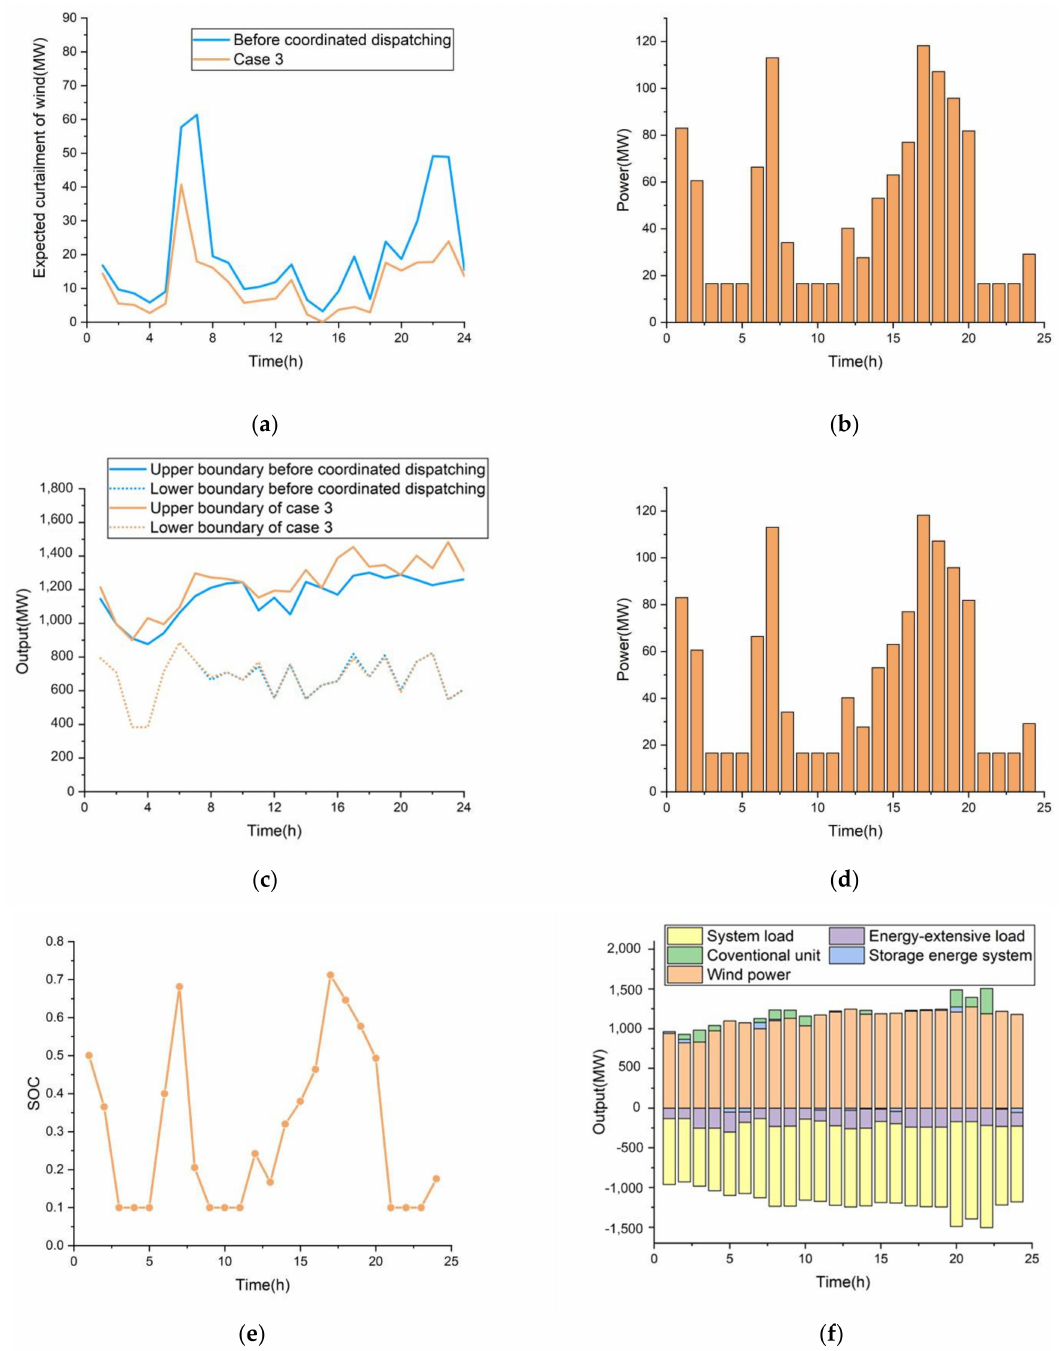
Figure 13. ( a ) Curves of expected curtailment of wind; ( b ) Curves of electricity plan of load; ( c ) ARWP boundary of power grid; ( d ) Charging and discharging of energy storage system; ( e ) Energy storage system SOC; ( f ) System coordination dispatching